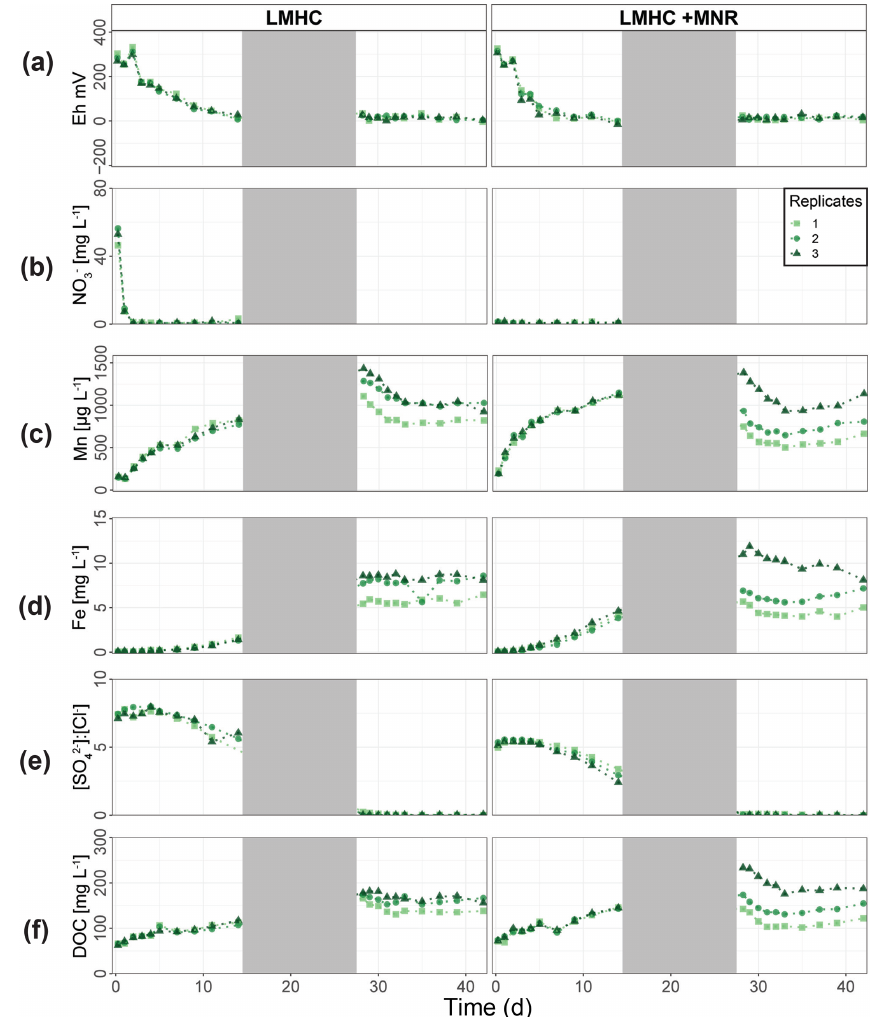
Figure 5. Soil solution dynamics in pasture field soil (LMHC) incubations for redox potential (a) , redox-reactive elements (NO − Fe, P-Fe, [SO 2 − ]:[Cl − ]) (b–e) and dissolved organic carbon (f) . Lines between points were plotted to improve readability. The gray area 4 indicates the drained